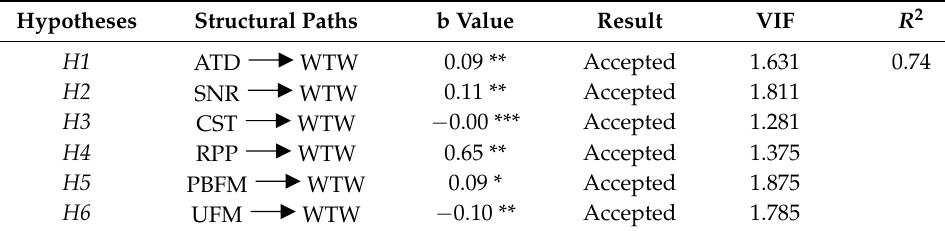
Table 6. Results of hypotheses.